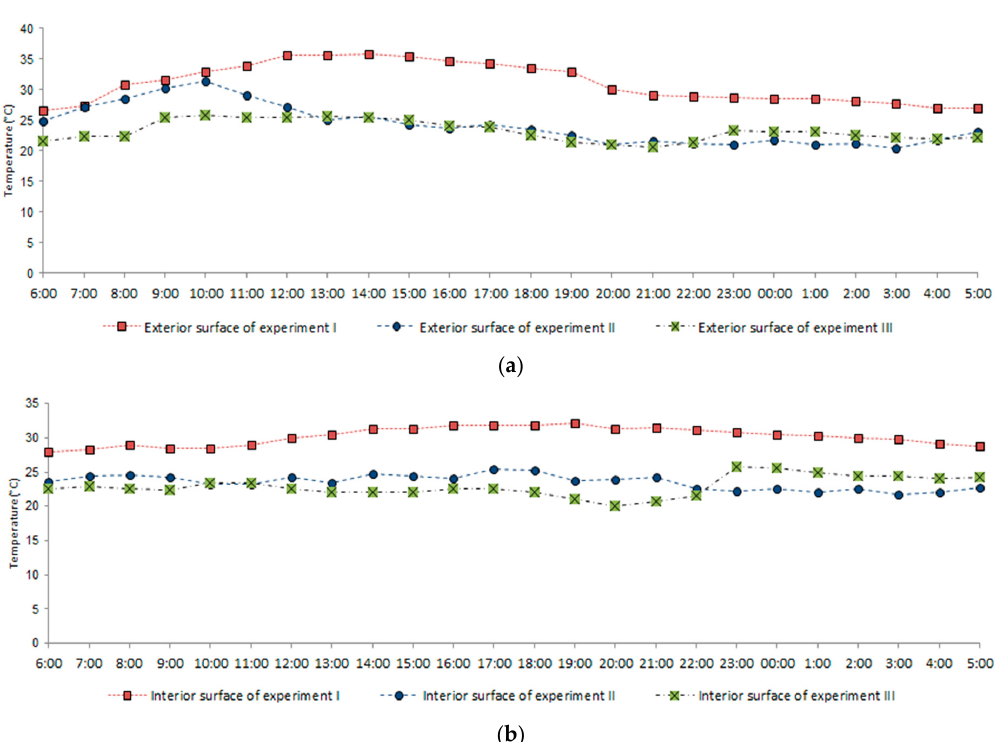
Figure 6. Comparison between: ( a ) exterior surface temperature and ( b ) interior surface temperature of bare wall and green facade.